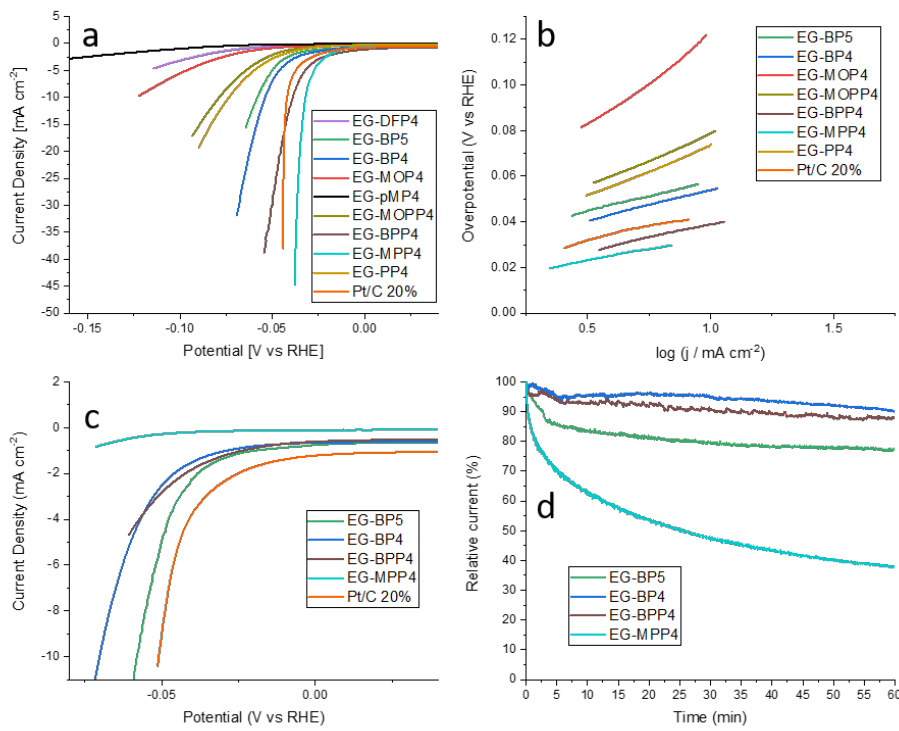
Figure 7. HER polarization curves of (EG/TAAIL)Pt-NPs ( a ), Tafel plots of the samples that reached an overpotential of 10 mA cm − 2 ( b ), polarization curves after a 1000 CV stability test ( c ), and the chronoamperometric current loss of selected samples ( d ). Table 4. Summary of electrochemical parameters for (TAAIL)Pt-NPs and